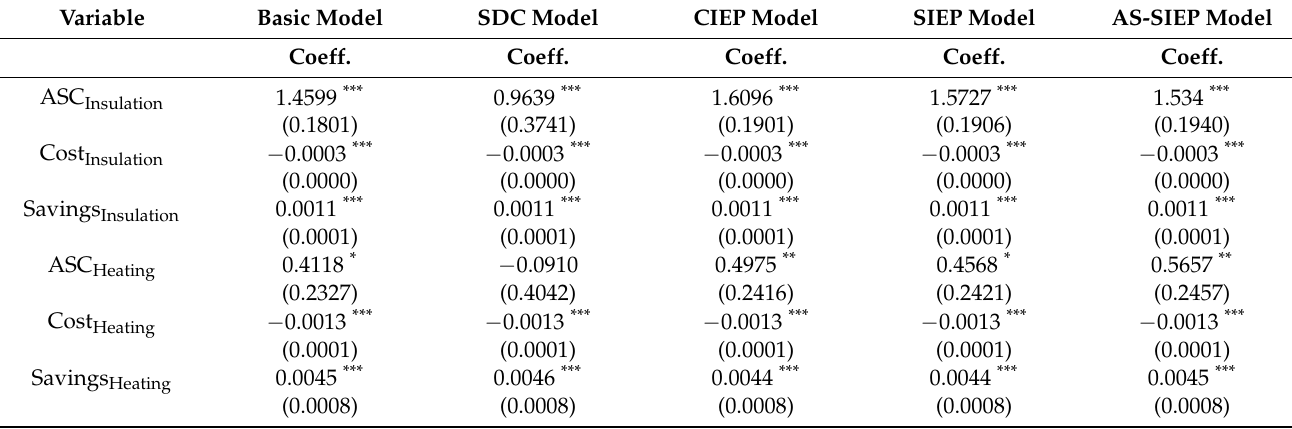
Table 3. Results of the basic, sociodemographic characteristics (SDC) and energy poverty